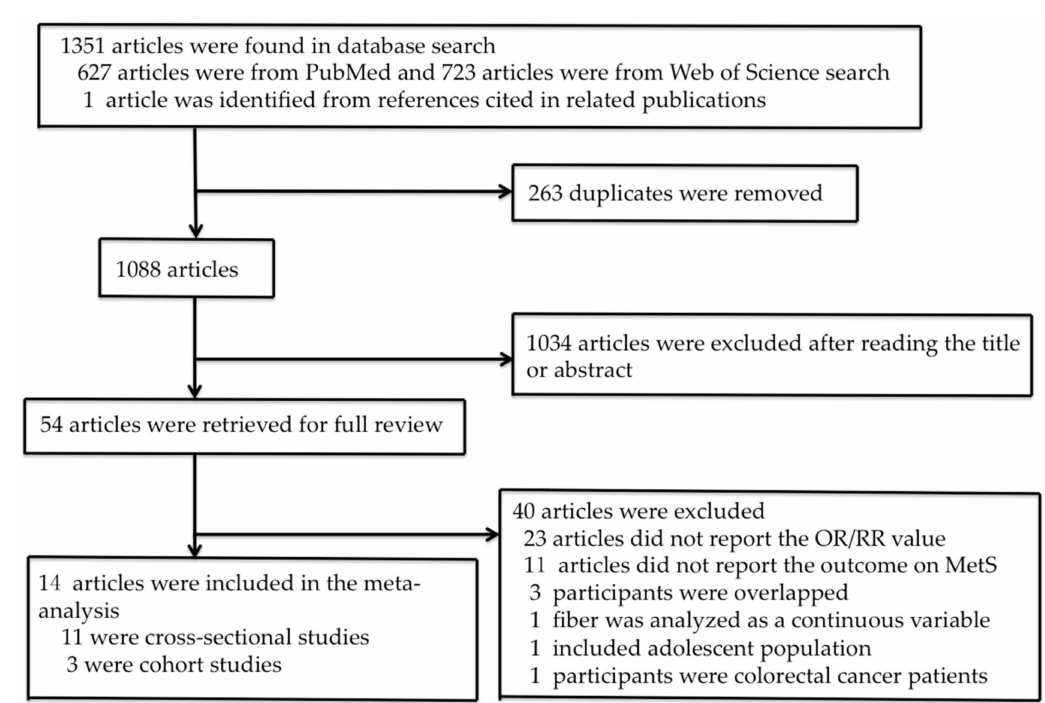
Figure 1. Flow chart of study